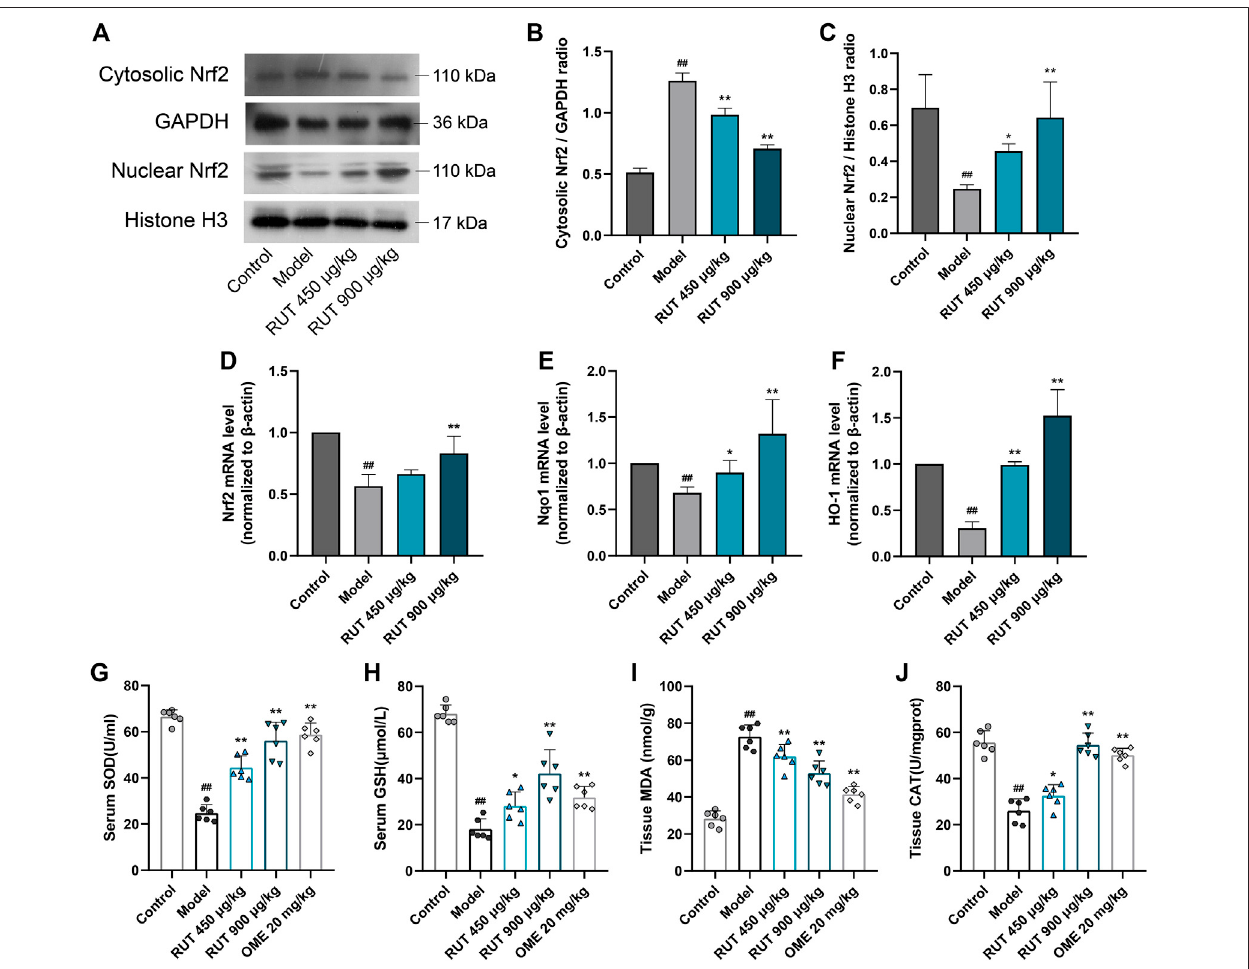
FIGURE 5 | Effect of RUT on oxidative stress factors levels in gastric damage induced by ethanol. Note: (A) Western blot images of cytosolic and nuclear Nrf2; (B) CytosolicNrf2 protein level; (C) Nuclear Nrf2protein level; (D) Nrf2 mRNAlevel; (E) Nqo1mRNA level; (F) HO-1mRNA level; (G) Serum SOD level; (H) Serum GSH level; (I) Tissue MDA level. Values are expressed as mean ± SD (n (cid:1) 6). # p < 0.05 and ## p < 0.01 when compared with the control group. * p < 0.05 and ** p < 0.01 when compared with the model group.